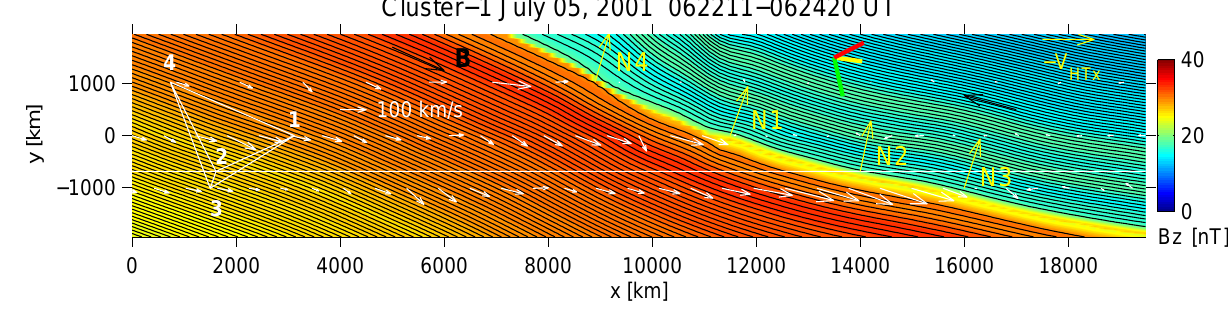
Fig. 9. Magnetic field map reconstructed by using a constant HT velocity for the C1 magnetopause crossing on 5 July 2001. The format is the same as in the upper panel of Fig. 3, except that for C1, C3, and C4, the flow vectors in the HT frame are projected as white arrows, and for C2, the spacecraft trajectory is shown by a white curve. In this plane the magnetotail ( B x > 0; B y < 0) is on the lower left side, whereas the magnetosheath ( B x < 0; B y > 0) is on the upper right side. The yellow arrows show the projections of the normal vectors determined from MVABC.